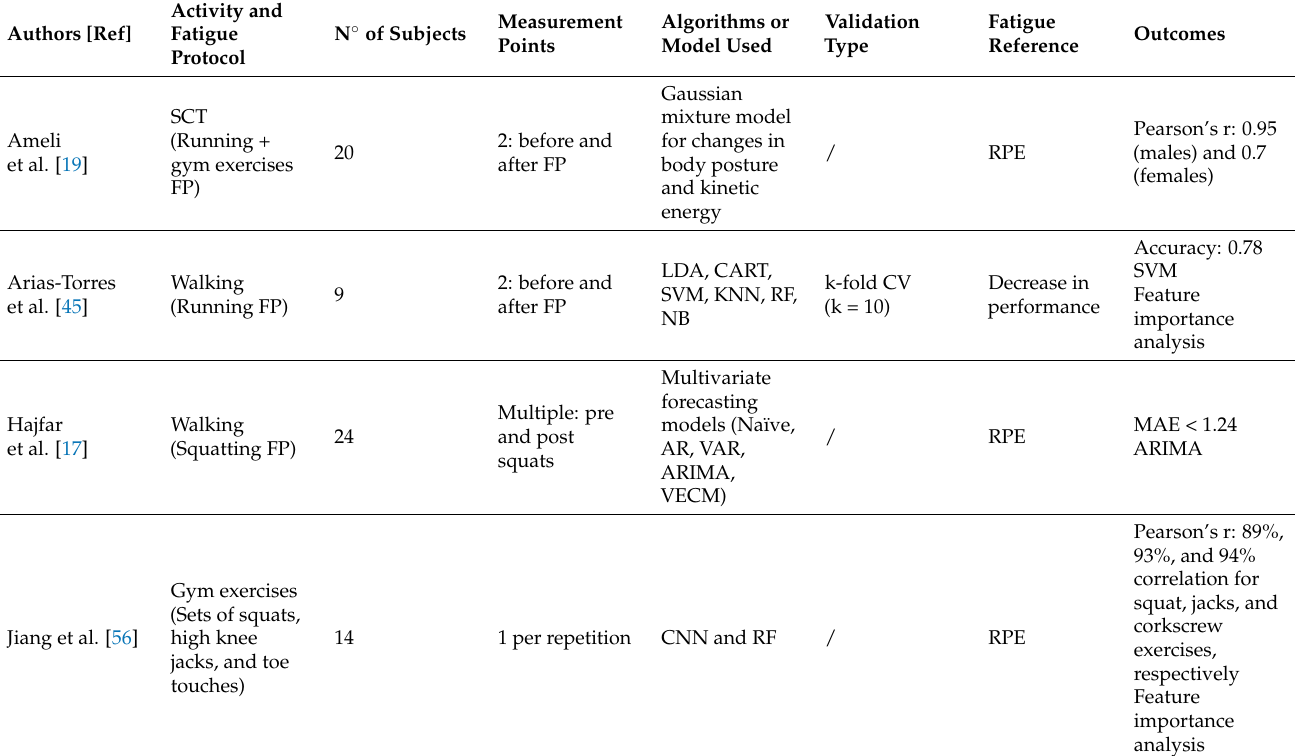
Table 8. Fatigue classification and prediction performance across all PE